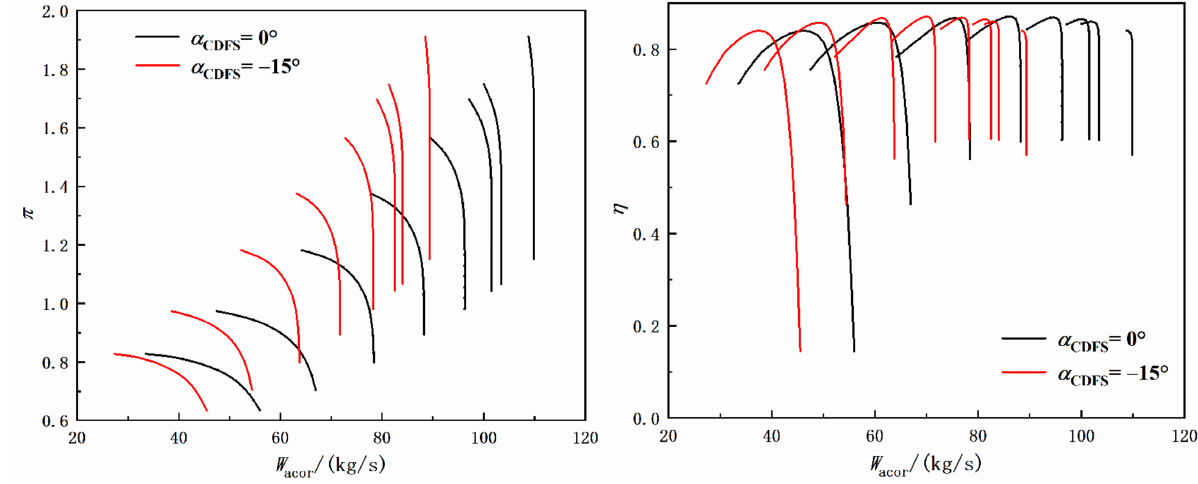
Figure 2. Characteristic maps of CDFS only multiplied by correction factor.